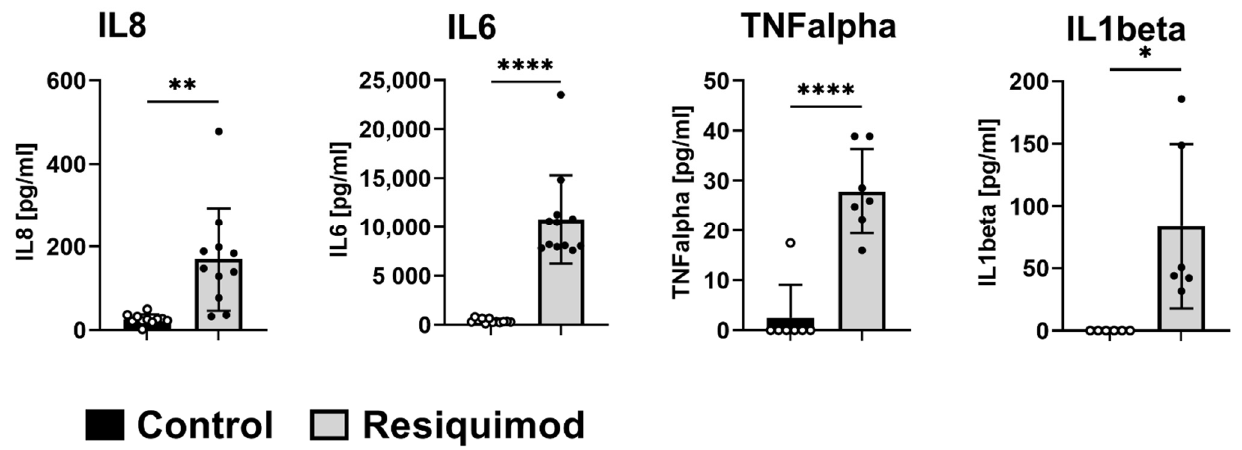
Figure 7. Short-term resiquimod application promotes the release of cytokines in the dermis. Release of cytokines into dISF was analysed by OFM. Split-thickness wounds were inflicted and treated with resiquimod and, 48 h later, OFM probes were implanted to sample dISF. Total IL8, IL6, TNFalpha and IL1b content was measured (n = 6–12 per treatment). Data are shown as mean ± SD. Statistical significance was determined by unpaired t-test with a Welch’s correction. * ( p < 0.05), ** ( p < 0.01), **** ( p < 0.0001).